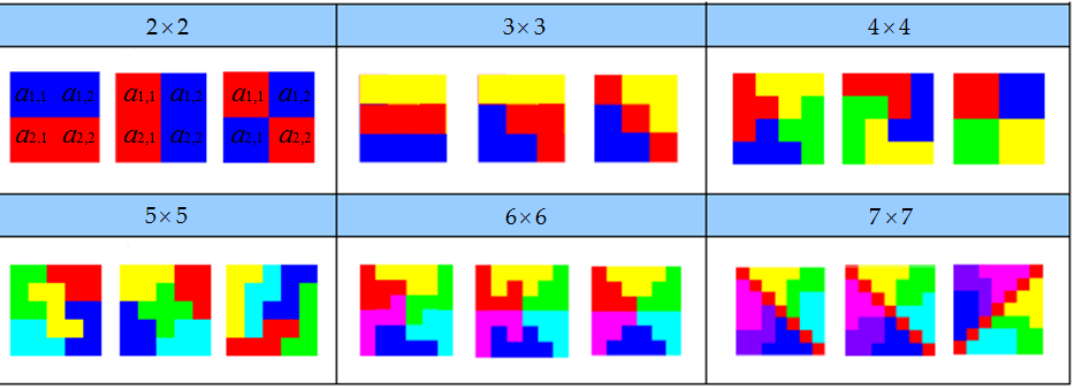
Figure 5. Use of computational geometry to divide the matrix into equal parts.